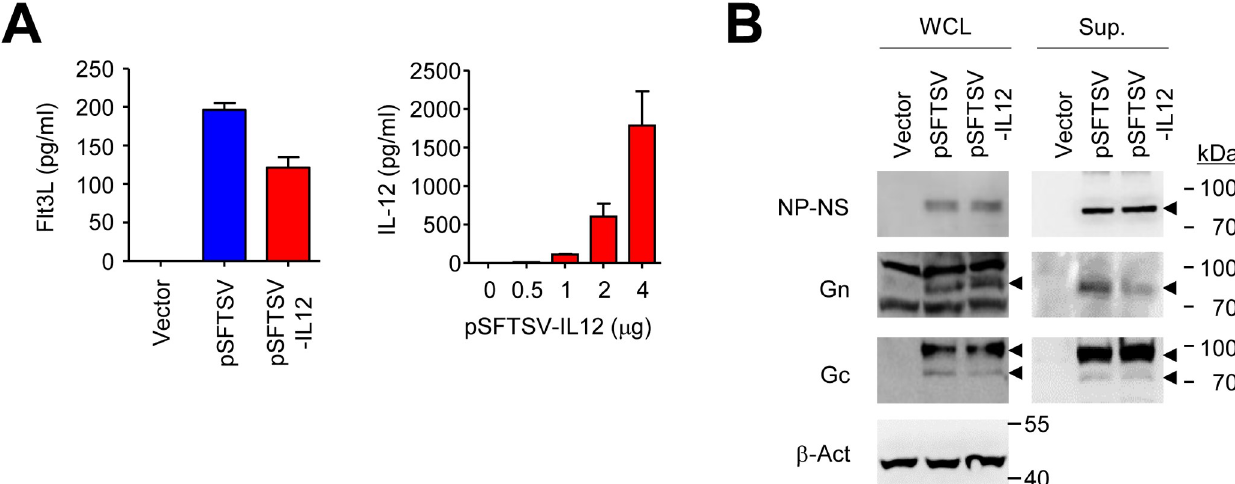
Fig 2. Characterization of gene expression after SFTSV DNA vaccine transfection. (A) Expression and secretion of the viral antigens and IL-12 in HEK293 cells transfected with the DNAs was confirmed by measuring the concentration of Flt3L and IL-12 in the cell culture supernatants by ELISA. Data are presented as mean + S.D. from triplicated experiments. (B) Expression of the viral antigens, Gn (~ 74 kDa), Gc (~ 71 kDa), and NP-NS fusion (~ 80 kDa) proteins, in cell lysates (left panels) and culture supernatants (right panels) of transfected HEK293 cells was assessed by immunoblot analysis using anti-Gn, Gc, or NP antibodies, respectively. The specific bands of antigens corresponding to their expected sizes are indicated with arrow heads. β -actin was used as loading control.